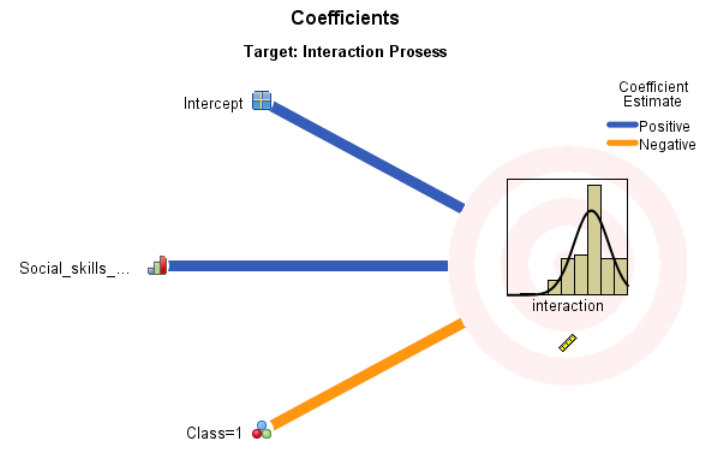
Figure 6. The estimated coefficient of the interaction process (source: created by